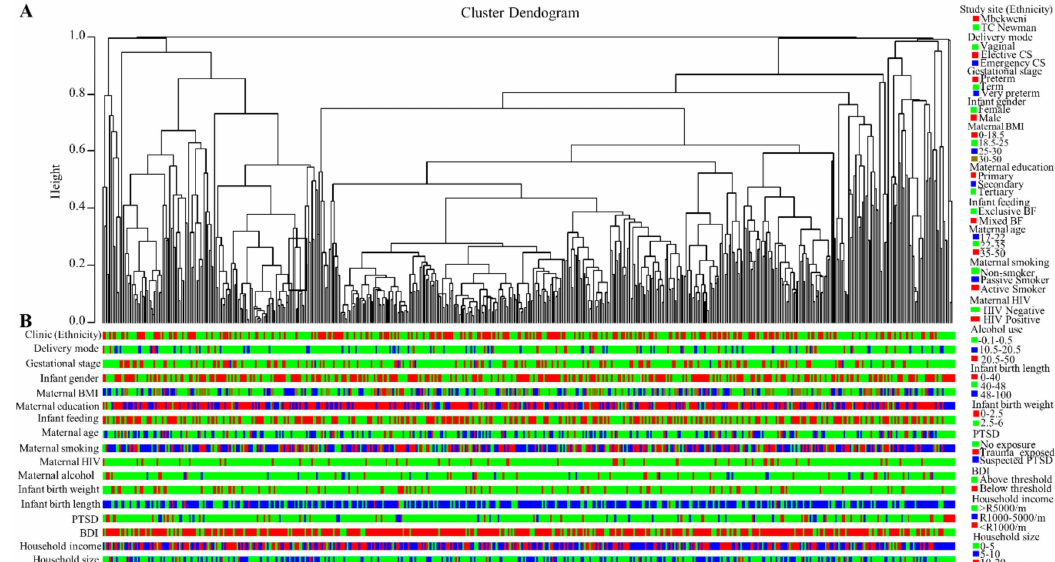
Figure 5. Complete linkage unsupervised hierarchical clustering of human breast milk (HBM) bacterial profiles. ( A ) Dendogram of bacterial profiles present in 522 HBM samples at genus level. ( B ) Horizontal colored bars below the dendogram summarize covariate data for each sample.